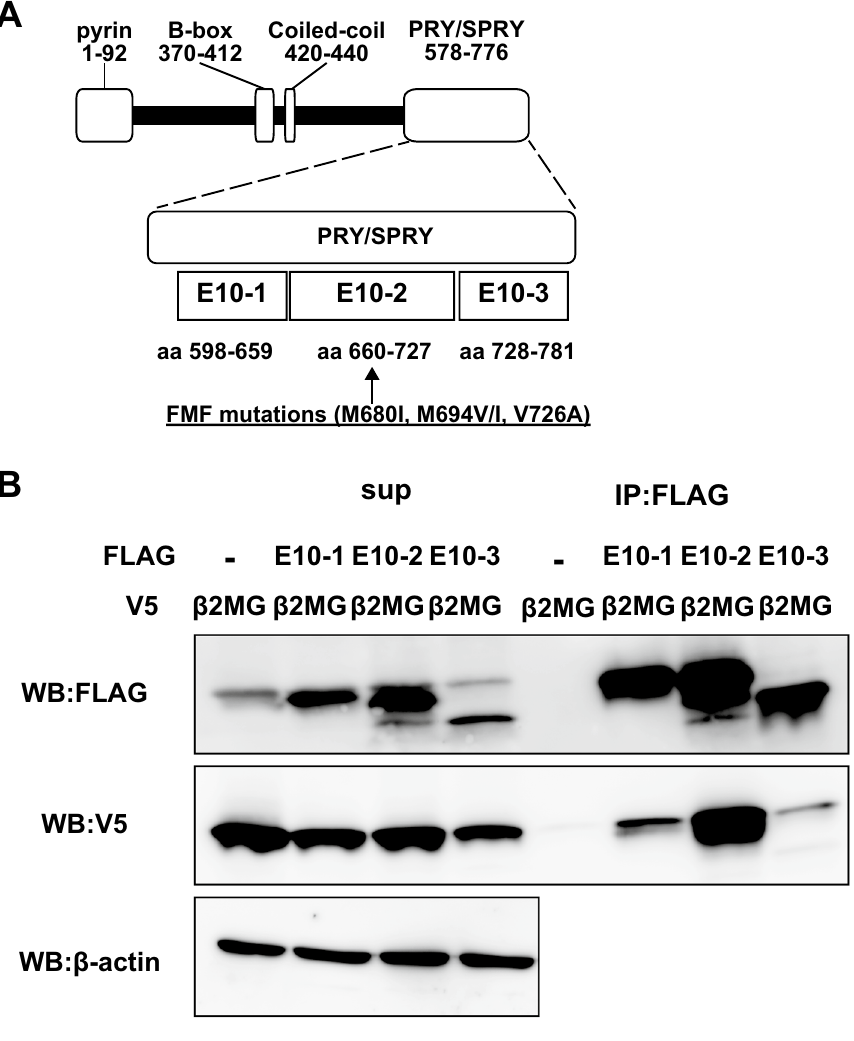
Figure 3. β2MG binds to the FMF mutation site. ( A ) Major MEFV mutations causing familial Mediterranean fever, M680I, M694I/V, and V726A, are concentrated in the middle portion of exon10 region (E10-2). ( B ) Lenti-X 293T cells expressing V5-β2MG and FLAG-tagged pyrin 10-1 (E10-1), 10-2 (E10-2), or 10-3 region (E10-3) were lysed with lysis buffer and subjected to co-immunoprecipitation analysis using FLAG Ab-conjugated agarose beads. Co-immunoprecipitation analysis reveals that β2MG binds to E10-2, which includes the hotspot of FMF-associated